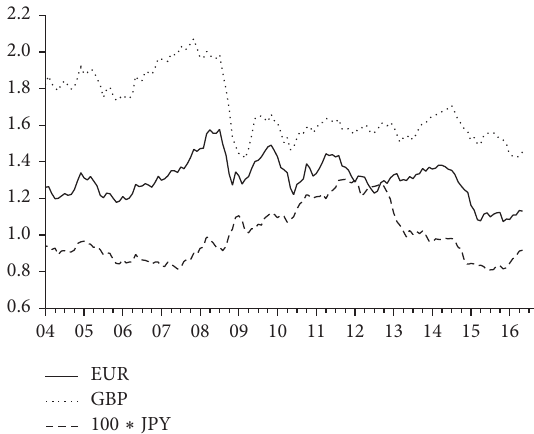
Figure 1: Plot of USD/EUR, USD/GBP, and USD/JPY for 2004M01- 2016M05.